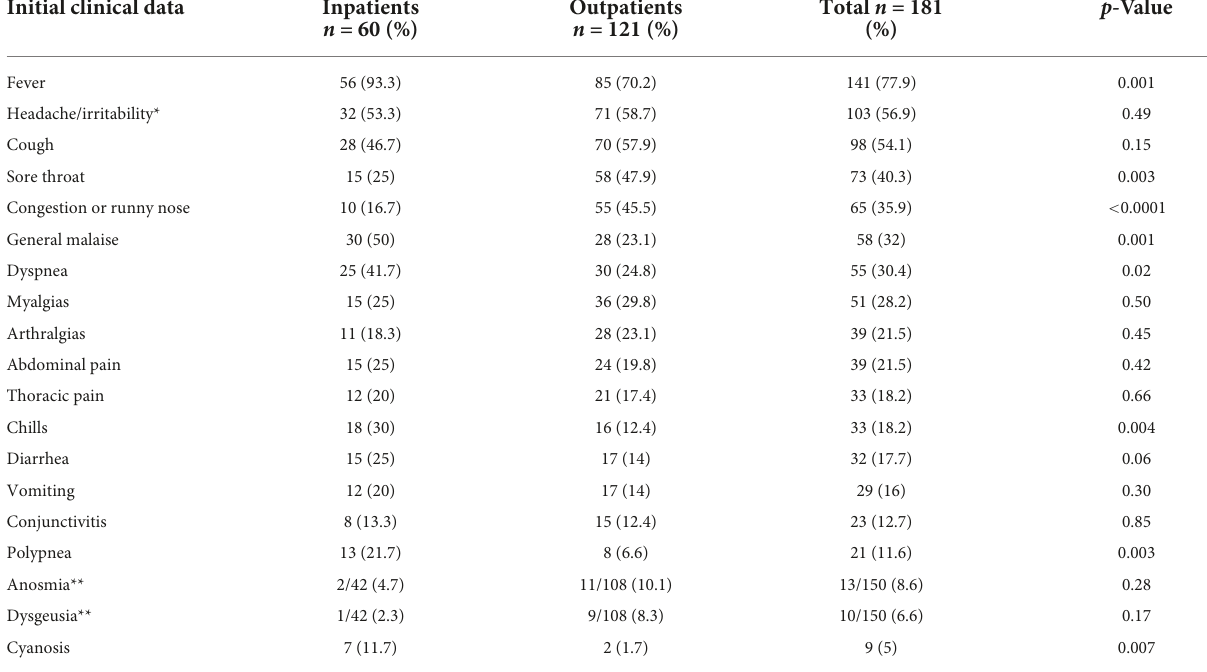
TABLE 2 Clinical characteristics in patients with SARS-CoV-2 infection. Initial clinical